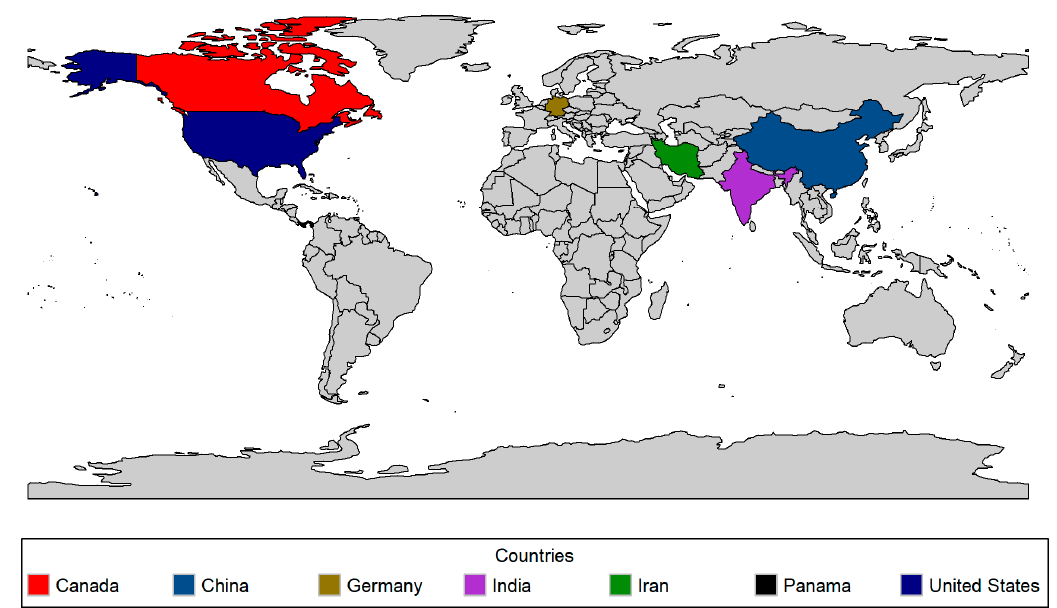
Figure 1. Distribution of the countries in which the study sites were located .